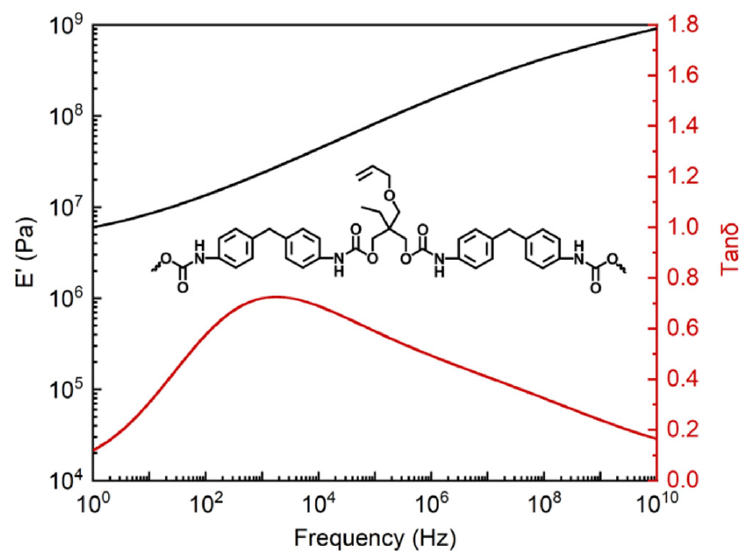
Figure 11. The E’ and tan δ of the PU ‐ based composite.